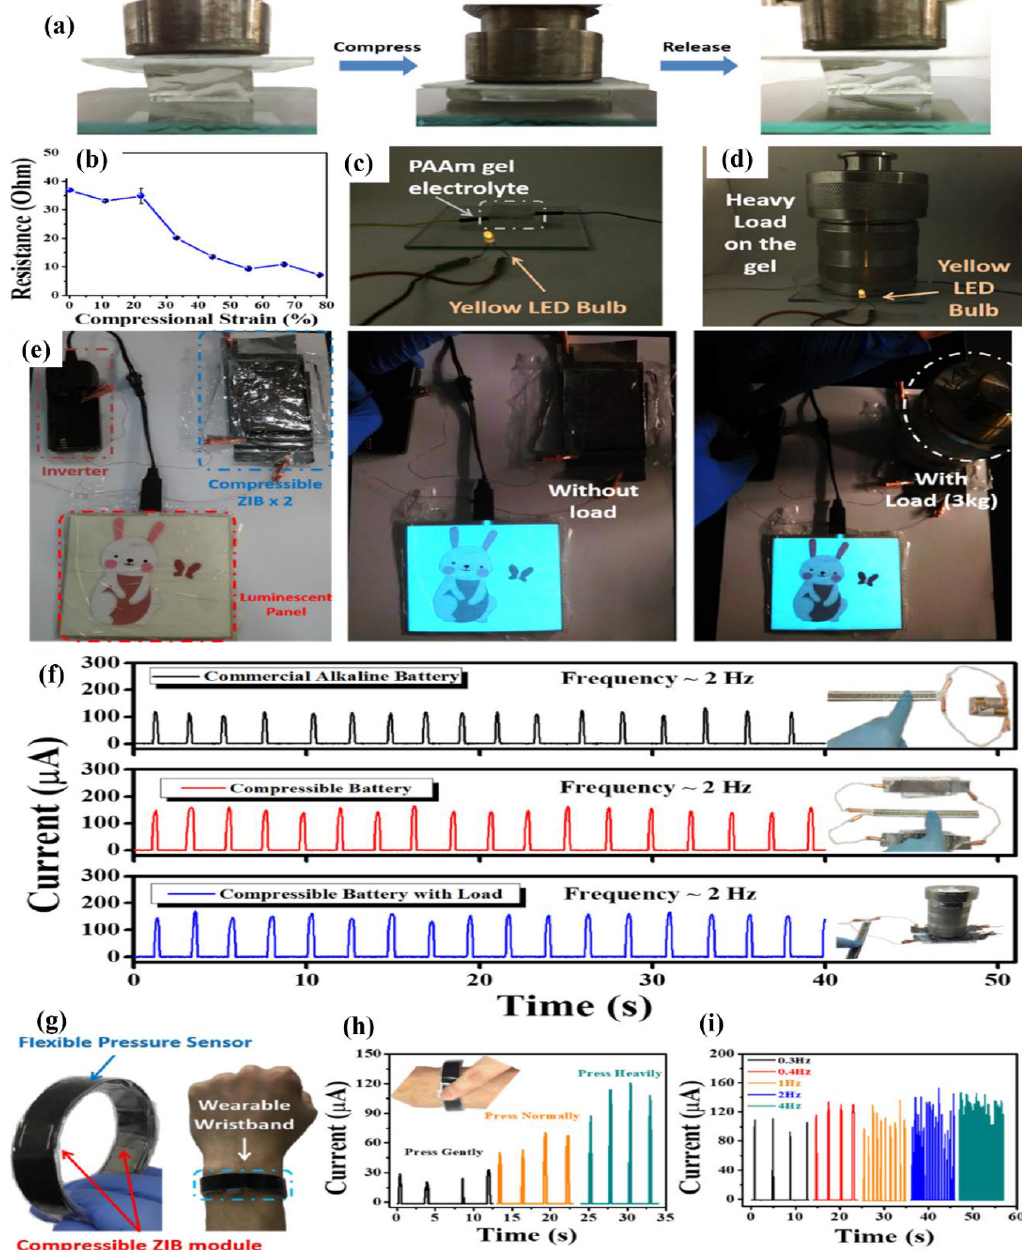
Figure 27. Compressibility of the poly (acrylamide) hydrogel electrolyte (PAAm). ( a ) Images showing the elasticity of hydrogel under compressional and relaxed states; ( b ) resistance values of the poly (acrylamide) hydrogel electrolyte under different compressional strain values from 0 to 77.8%; ( c , d ) pictures showing the conductivity of hydrogel electrolyte under relaxed and compressional states with the ability to light a yellow light-emitting diode (LED) bulb; ( e ) optical images showing that two rechargeable Zn–MnO 2 batteries with poly (acrylamide) hydrogel electrolytes could be used for powering a luminescent panel under normal condition and with a 3-kg load on it; ( f ) comparison between the signals generated by the flexible sensor powered by the commercially available alkaline batteries and our compressible batteries without and with q load on top of it; ( g ) flexible smart wristband integrated from two ZIB modules and a flexible pressure sensor; ( h ) sensory signals of the smart wristband generated by human finger touch under different pressures on the device; ( i ) sensory signals of the smart wristband generated at different frequencies, from 0.3 to 4 Hz, by human finger touch [208].